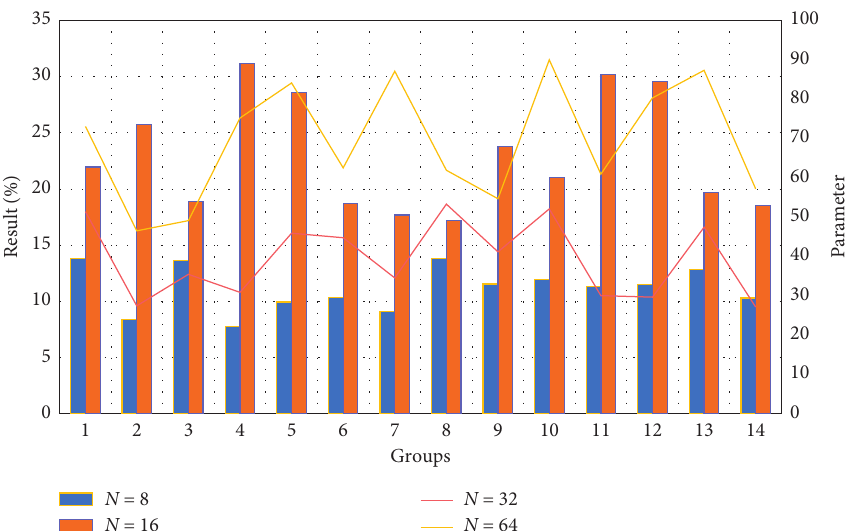
Figure 13: Efficiency analysis